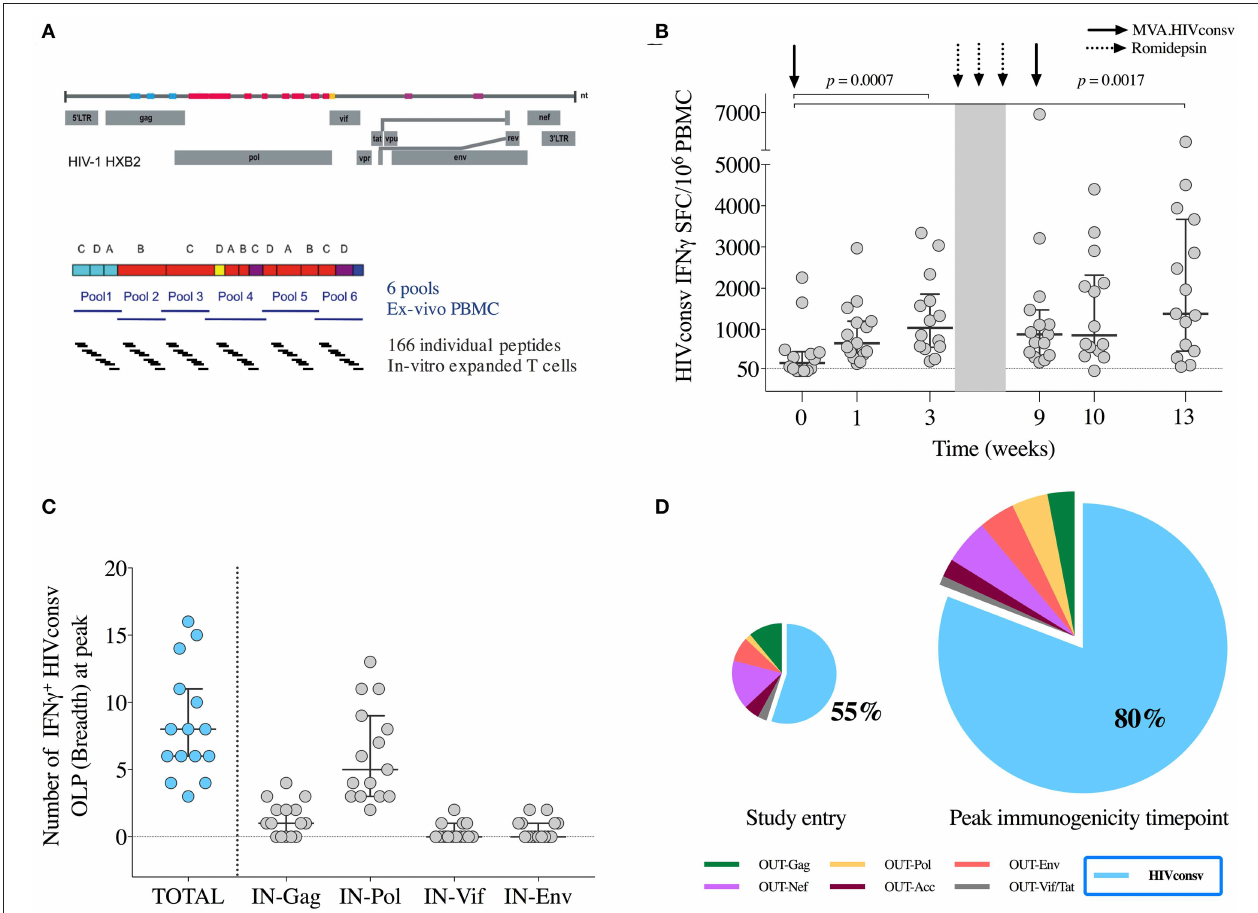
FIGURE 3 | Vaccine immunogenicity. (A) Schematic representation of the selected regions in the HIV-1 proteome from different clades included in the HIVconsv immunogen and distribution of 6 peptide pools (P1-P6) and individual overlapping 15-mer peptides (OLP) used in the IFN- γ ELISPOT assays. (B) Magnitude (sum of SFU/10 6 PBMC to pools P1-P6) of vaccine-induced responses over the BCN02 study. Horizontal and error bars represent median and IQR, respectively, and p -values correspond to comparisons between the indicated time points using the Wilcoxon signed-rank test. (C) Breadth of vaccine-elicited responses toward individual OLP included in the indicated HIVconsv regions. Horizontal and error bars represent median and IQR, respectively. (D) Average distribution of total HIV-1 T-cells according to their specificity at the indicated time points. HIVconsv-specific responses are shown in blue. Pie charts are scaled according to the total frequencies of responses. IN are peptide pools corresponding to the HIVconsv vaccine insert and OUT peptide pools spanning the rest of HIV-1 proteome “outside the